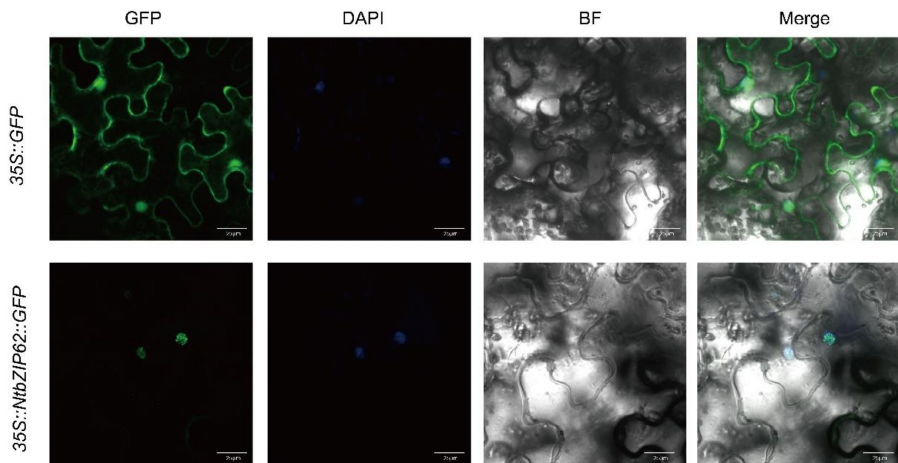
Figure 8. Subcellular localization of NtbZIP62. The coding sequence of NtbZIP62 was inserted into pCAMBIA1300-GFP vector and transiently expressed in N.benthamiana leaves. The location of the nucleus was determined by 4,6-diamidino-2- phenylindole (DAPI) staining.